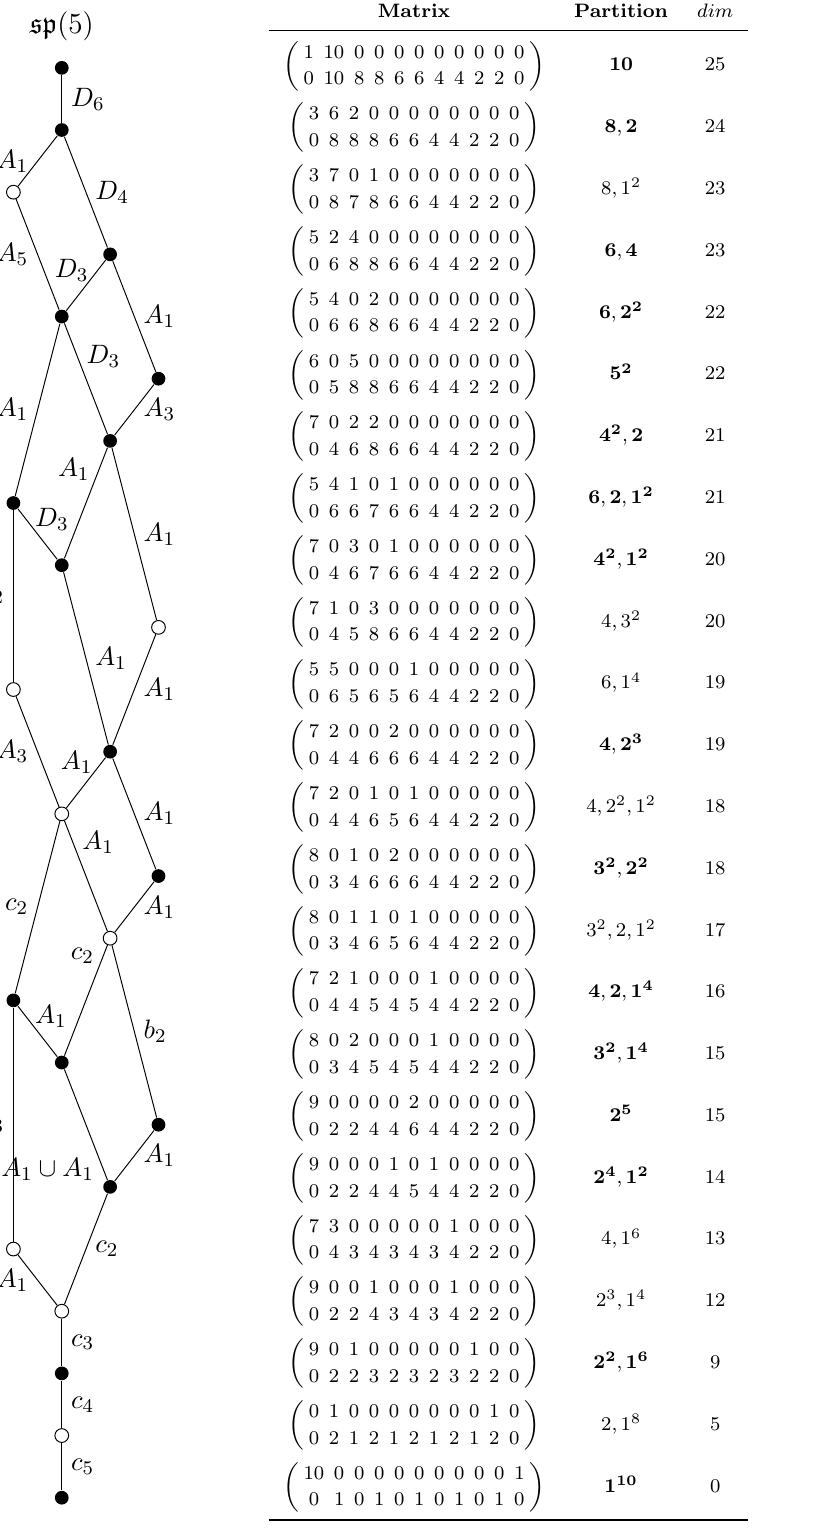
Table 23. Results obtained applying the matrix formalism to sp